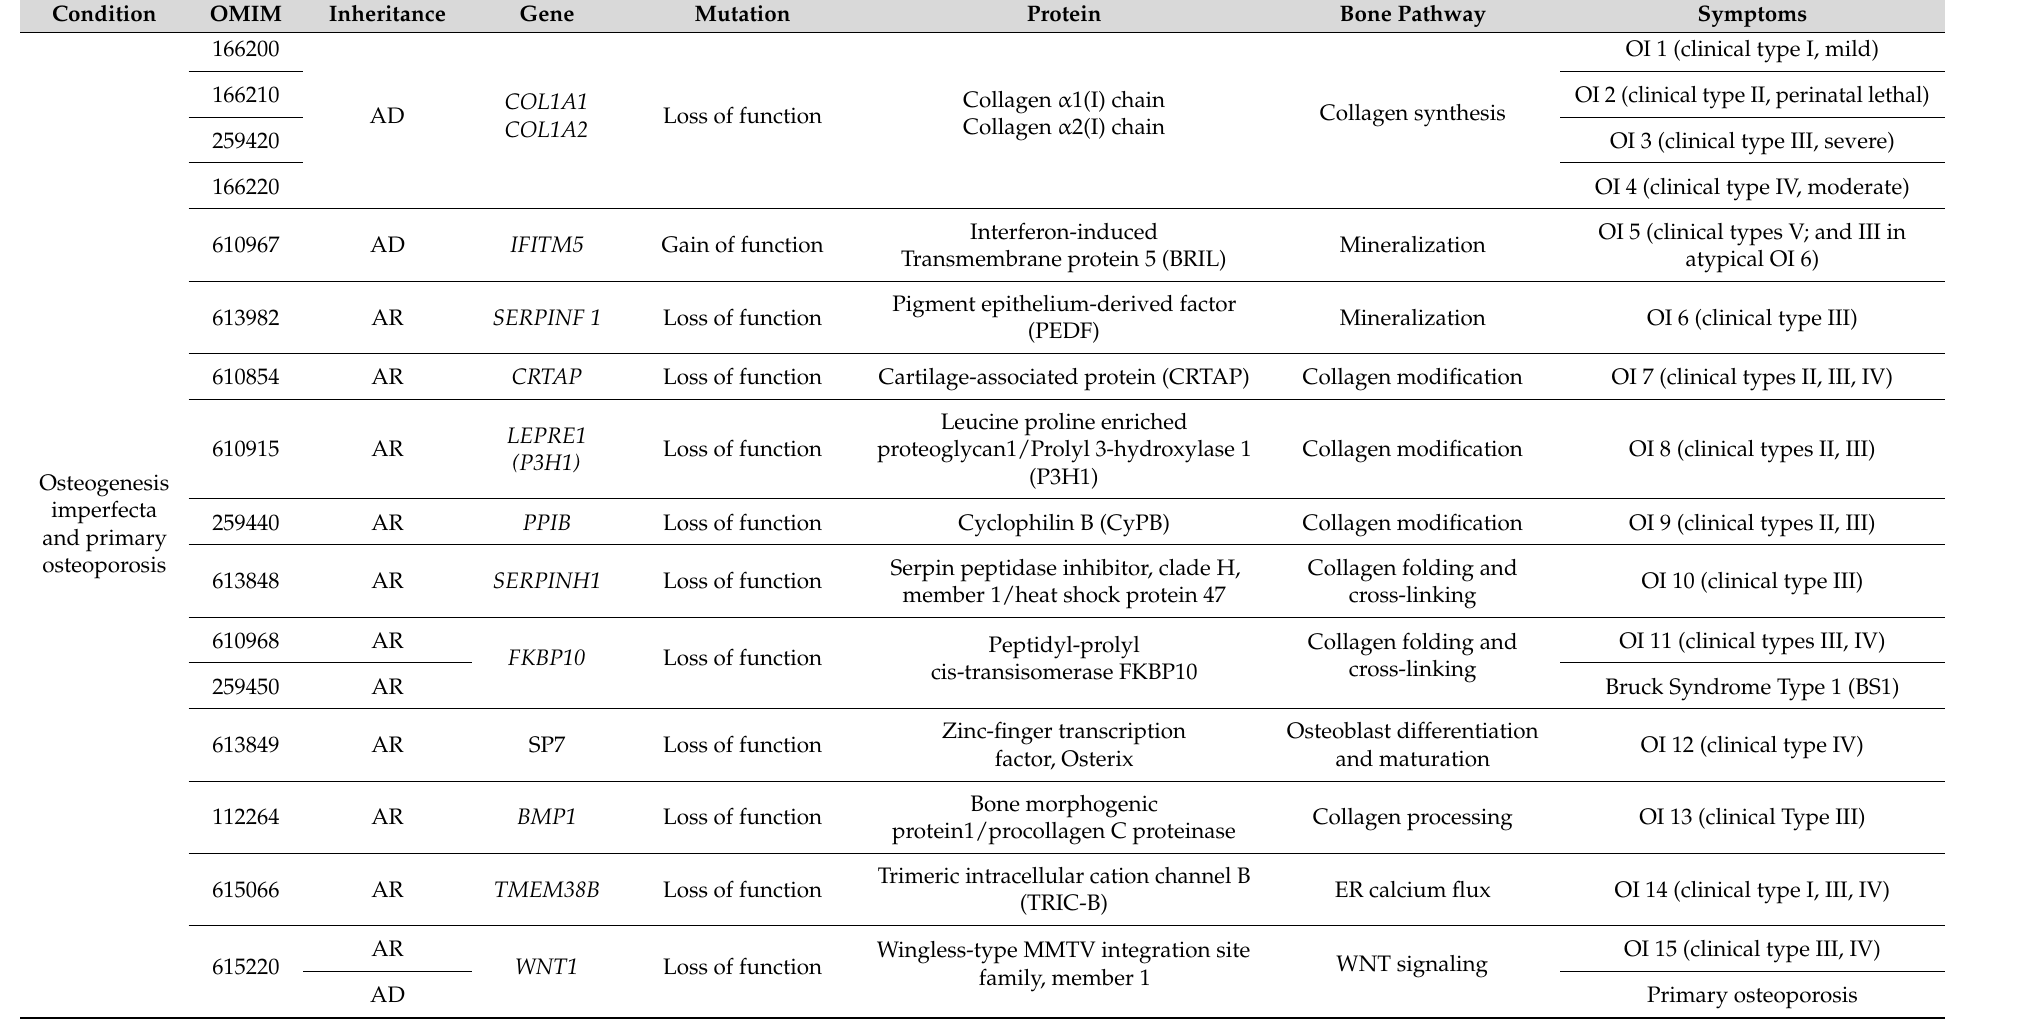
Table 1. Bone fragility conditions with low bone mass: inheritance, gene defects, protein function and clinical characteristics, grouped by genes causing osteogenesis imperfecta, other primary osteoporosis and